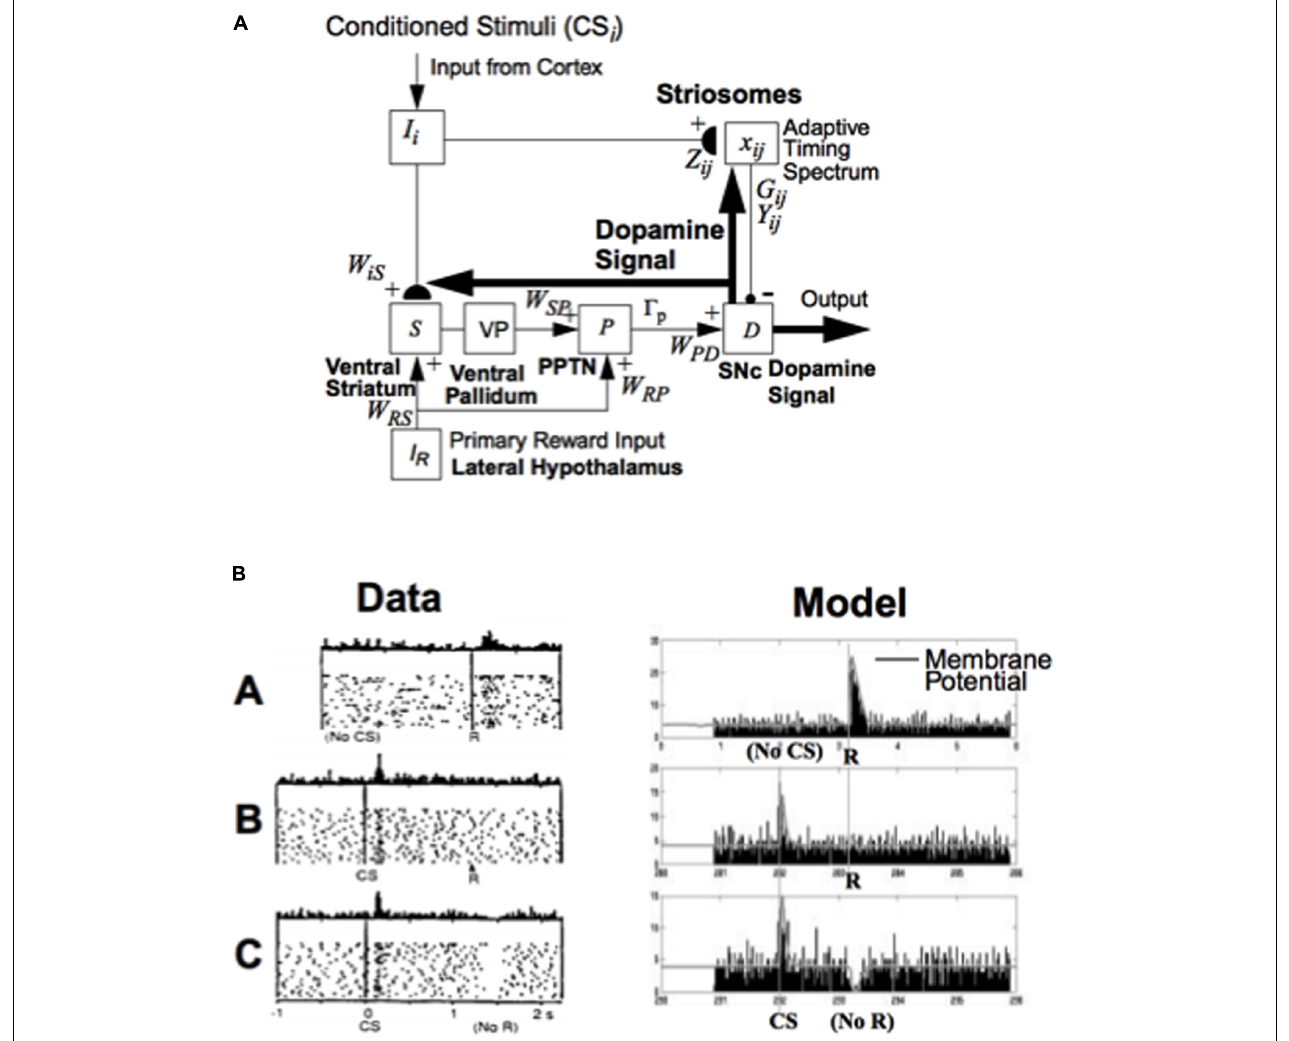
FIGURE 5 | How the basal ganglia generate a dopaminergic Now Print learning signal to multiple brain regions in response to rewards whose timing or amplitude are unexpected: (A) Model circuit for triggering dopaminergic Now Print signals at the substantia nigra pars compacta (SNc) to multiple brain regions in response to unexpected rewards. Cortical inputs (I i ) that are activated by conditioned stimuli learn to excite the SNc (D) via the (ventral striatal, S)-to-(ventral pallidal, VP)-to-(PPTN, P)-to-SNc path. The inputs I i excite the ventral striatum via adaptive weights W iS , and the ventral striatum excites the PPTN via double inhibition through the ventral pallidum, with weights W SP . When the PPTN activity exceeds a threshold (cid:48) p it excites the dopamine cell with weighted strength W PD . The striosomes, which contain an adaptive spectral timing mechanism (x ij , G ij , Y ij , Z ij ), learn to generate lagged, adaptively timed signals that inhibit reward-related activation of SNc. Primary reward signals (I R ) from the lateral hypothalamus both excite the PPTN directly (with weighted strength W RP ) and act as training signals to the ventral striatum S (with weighted strength W RS ). Arrowheads denote excitatory pathways, circles denote inhibitory pathways, and hemidisks denote synapses at which learning occurs. Thick pathways denote dopaminergic signals. (B) Dopamine cell firing patterns: Left: Data. Right: Model simulation, showing model spikes and underlying membrane potential. (A) In naive monkeys, the dopamine cells fire a phasic burst when unpredicted primary reward R occurs; e.g., if the monkey receives a burst of apple juice unexpectedly. (B) As the animal learns to expect the apple juice that reliably follows a conditioned stimulus (CS) that precedes it by a fixed time interval, then the phasic dopamine burst disappears at the expected time of reward, and a new burst appears at the time of the reward-predicting CS. (C) After learning, if the animal fails to receive reward at the expected time, a phasic depression in dopamine cell firing occurs. Thus, these cells reflect an adaptively timed expectation of reward that cancels the expected reward at the expected time. [The data in (B) (column 1) are reprinted with permission from Schultz et al. (1997)]. [The model diagram in (A) and data simulation in (B) (column 2) are reprinted with permission from Brown et al.